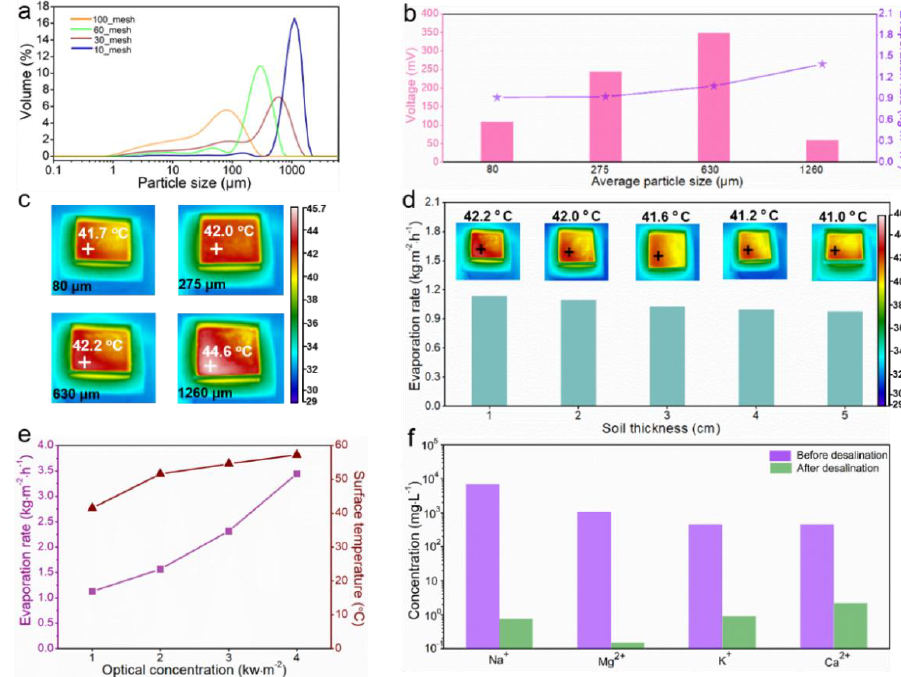
Figure 3. ( a ) Particle size distribution graph of 10_, 30_, 60_, and 100_mesh rocky land; ( b ) Induced voltage and water evaporation rate of rocky land with different particle sizes; ( c ) The surface tem- perature of different particle sizes under 1-sun irradiation for 1 h; ( d ) The water evaporation rate in rocky land with various thicknesses and the surface temperature of different thicknesses under 1-sun irradiation for 1 h; ( e ) The water evaporation rate in rocky land under 1 to 4-sun irradiation; ( f ) Concentration measurement of four main ions in seawater sample before and after